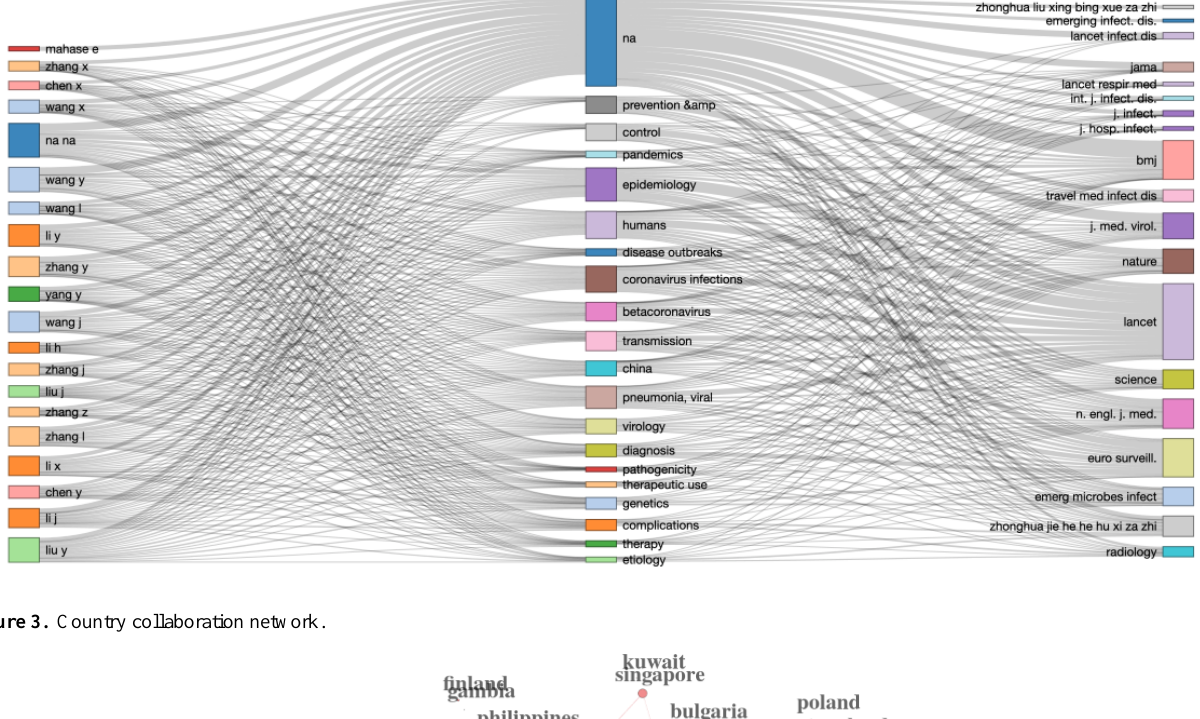
Figure 2. Sankey diagram: authors <> keywords <> sources.